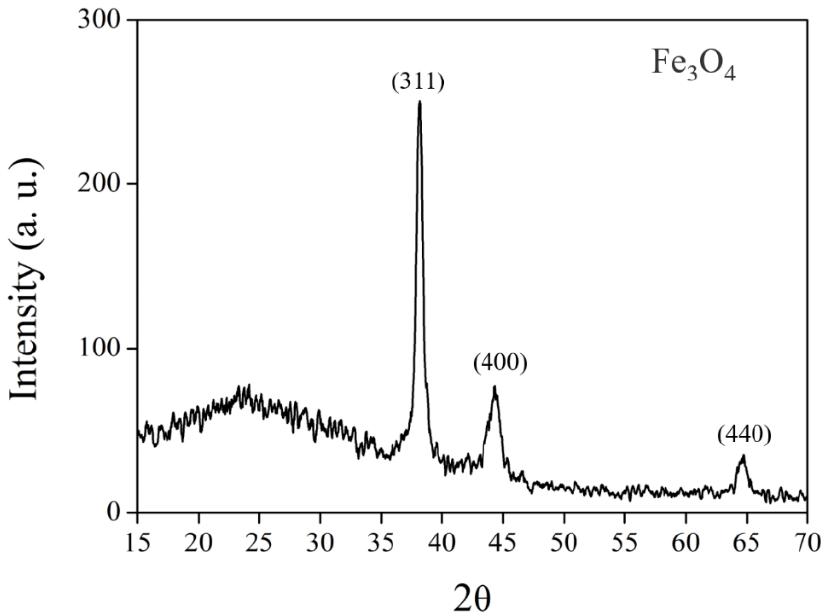
Figure 2. XRD pattern of PLIP-synthesized magnetic NPs indicating the Fe 3 O 4 crystalline structure.